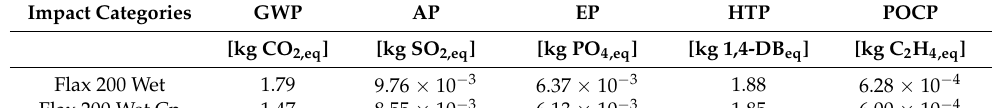
Table 7. Comparison of the total impacts of producing one flax panel with resources closer to local production .